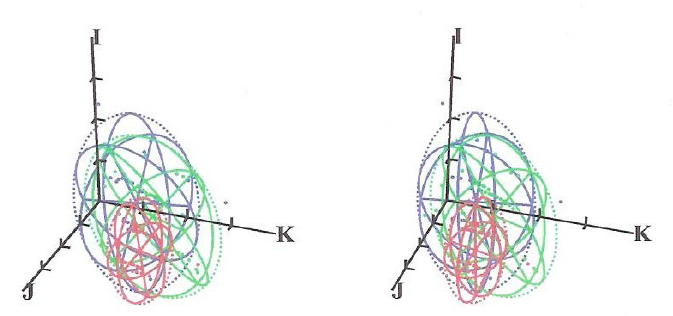
Figure 9: Stereo-pair scatter plot of fifty measurements of refractive stte taken from subject 5 wearing a Biofinity silicone hydrogel lens. The origin of the axes is at 0.5 I D.